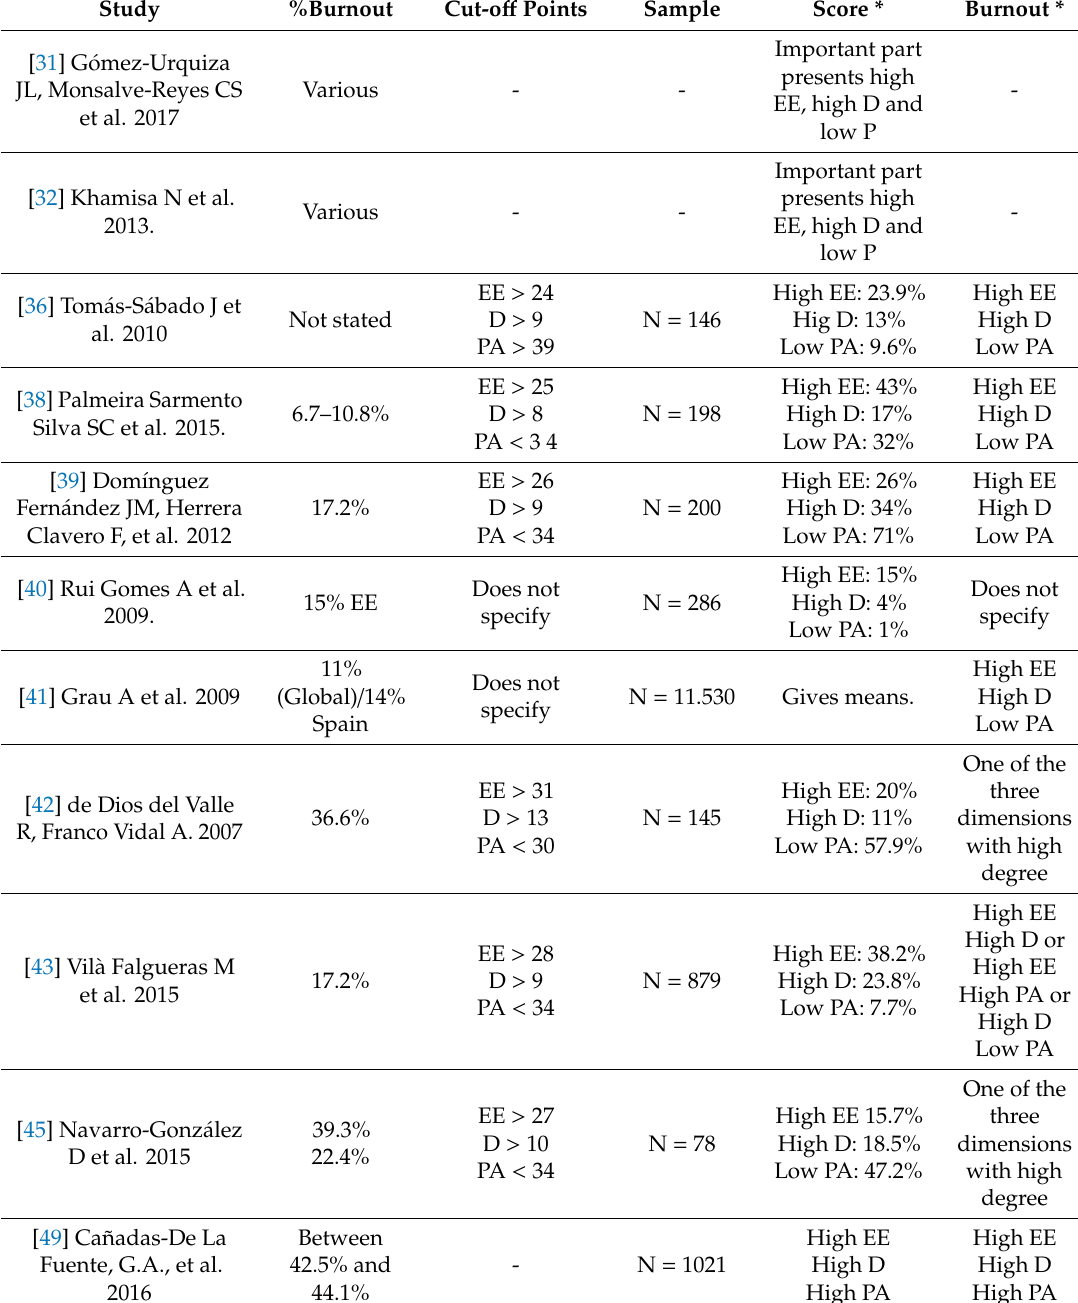
Table 2. Use of MBI in